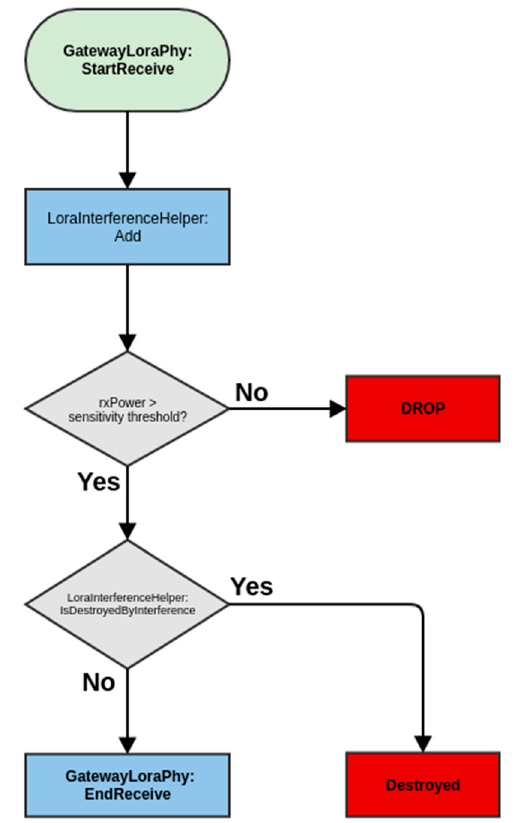
Figure 7. The interference model in the LPWAN module (illustration of procedures 4.2 and 4.3 in